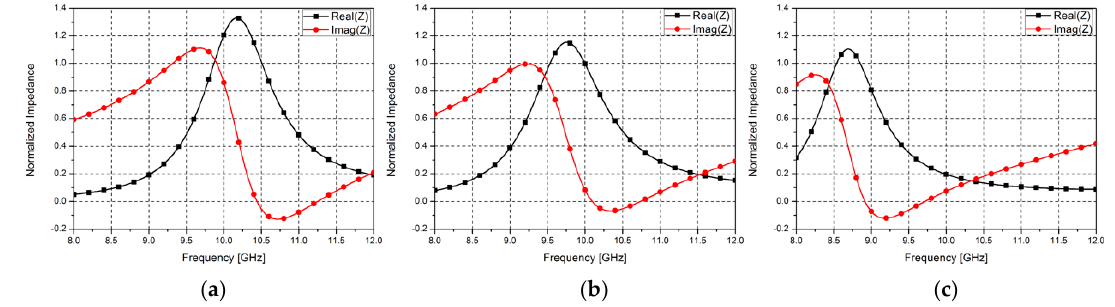
Figure 4. Simulated normalized impedance for ( a ) empty channel state; ( b ) channel filled with ethanol; and ( c ) channel filled with DI water.